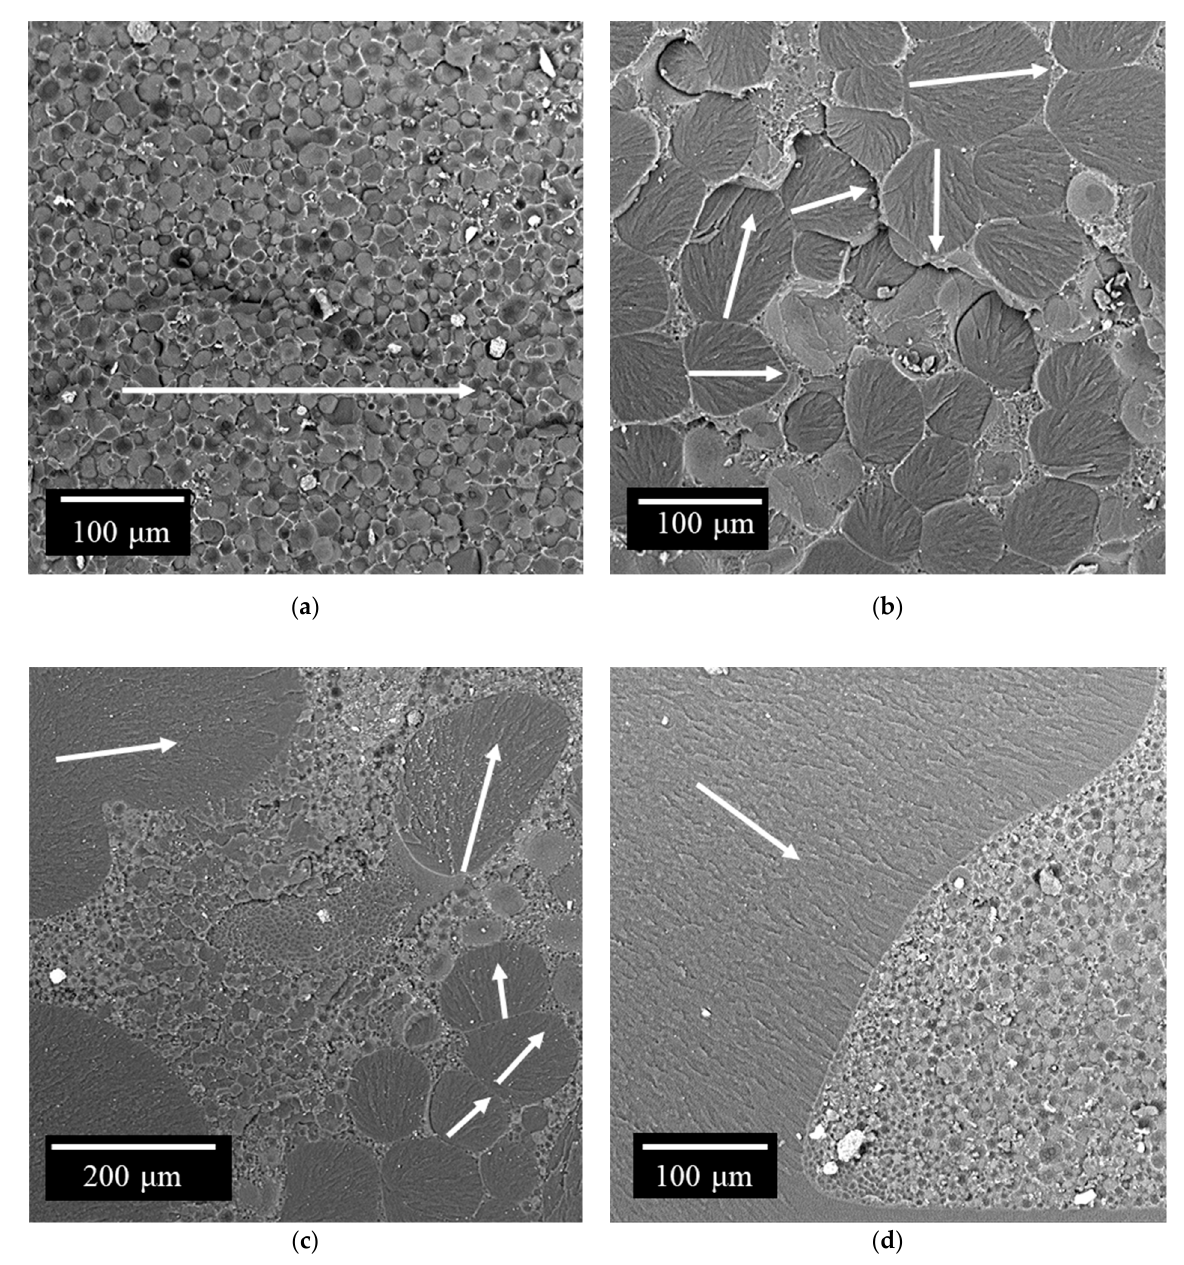
Figure 7. Micrographs of the surface of cracks in the epoxy matrix cured with TEAT and modified PSU/FGE (wt %): ( a ) 20/0; ( b ) 20/10; ( c ) 20/20; ( d ) 15/20.